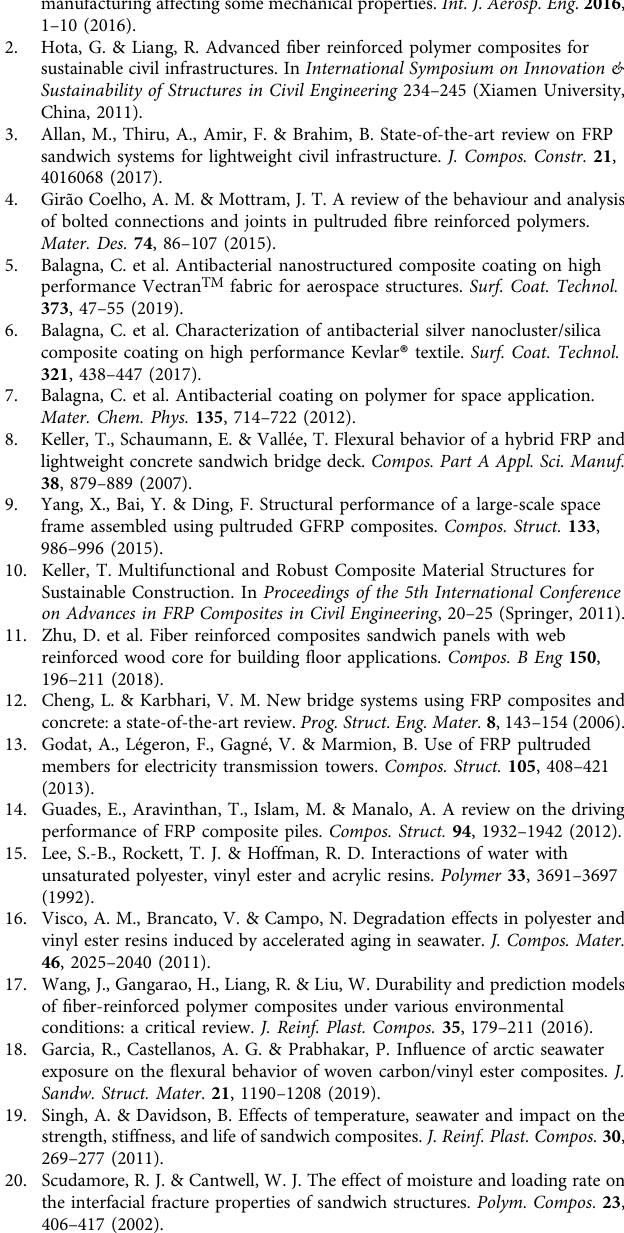
Figtree (http://tree.bio.ed.ac.uk/software/ fi gtree) iTOL 81 . To generate the phylogenetic tree seen in Fig. 6, an unrooted form of the phylogenetic tree was obtained from iTOL. The unedited tree can be accessed at http://itol.embl.de/ shared/breister2. The alignment used to generate the phylogenetic tree in